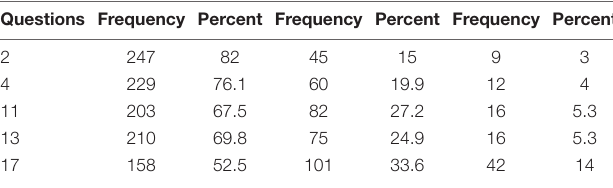
TABLE 2 | Frequency and percent of the questions related to the efficacy of technology integration.